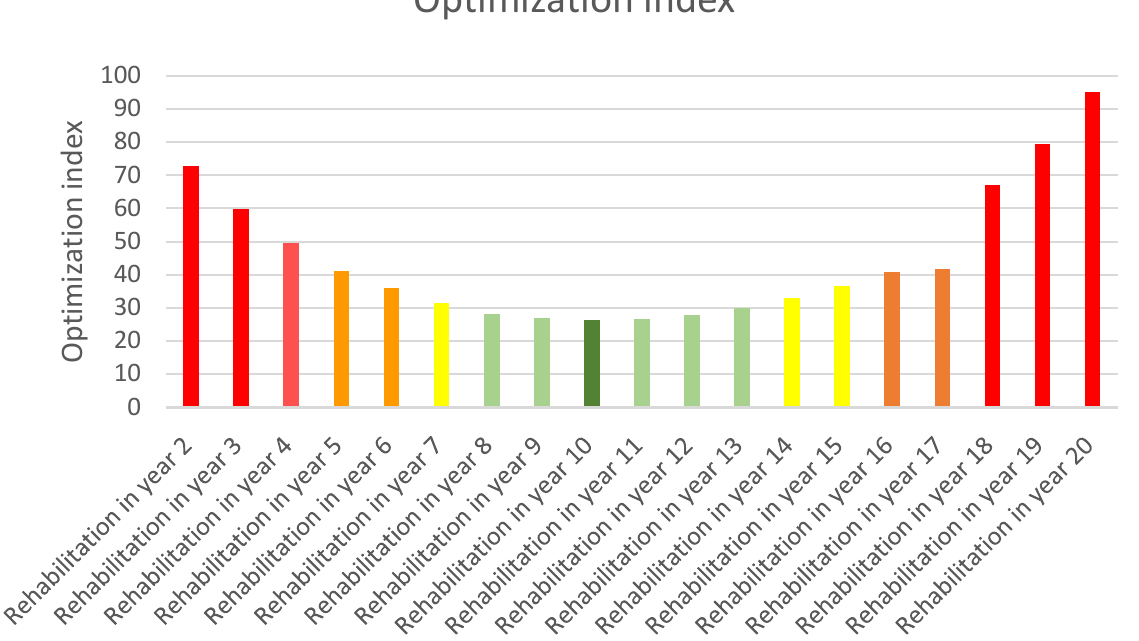
Figure 8. Optimization index — case study.